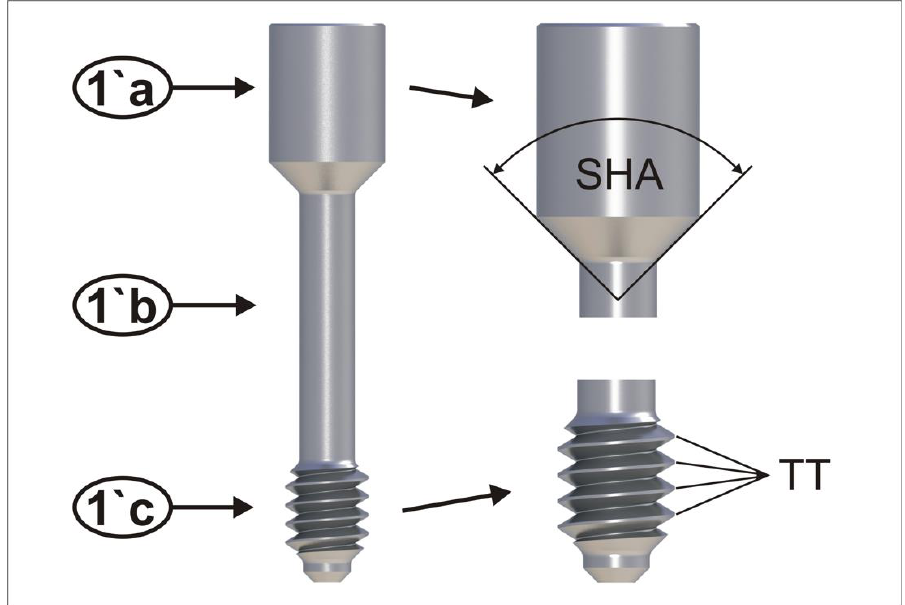
Figure 2. ( a – c ) parts of an abutment screw (1´a screwhead; 1´b screw shaft; 1´c screw thread) screwhead angle (SHA) of 90 degrees; 4 thread turns (TT´s).